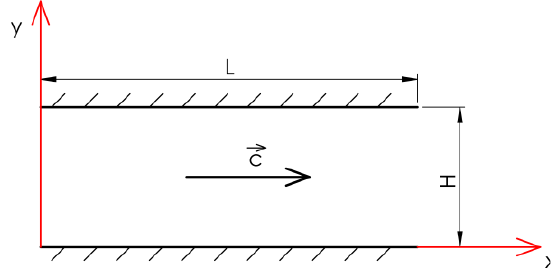
Fig. 2. Coordination